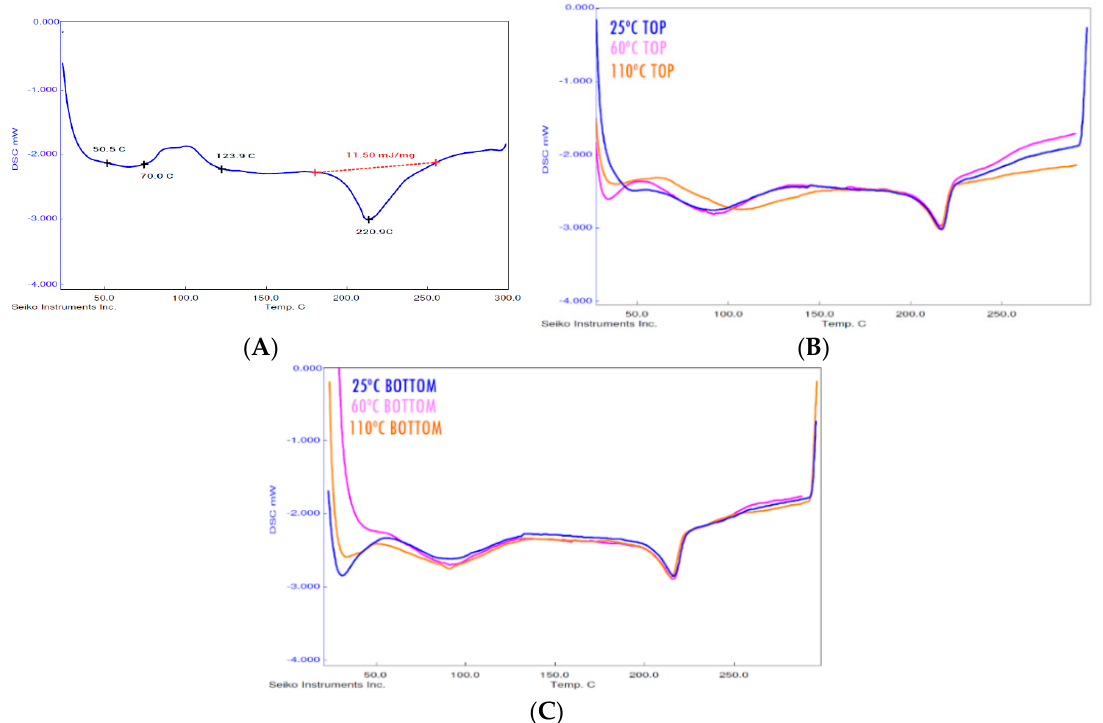
Figure 3. The DSC analysis of the samples printed at different built plate temperatures to analyse the influence of the thermal environment on the degree of crystallinity. The DSC analysis of raw material is shown in ( A ), the top parts are the analyses shown in ( B ) and the bottom parts are the analyses shown in ( C ).